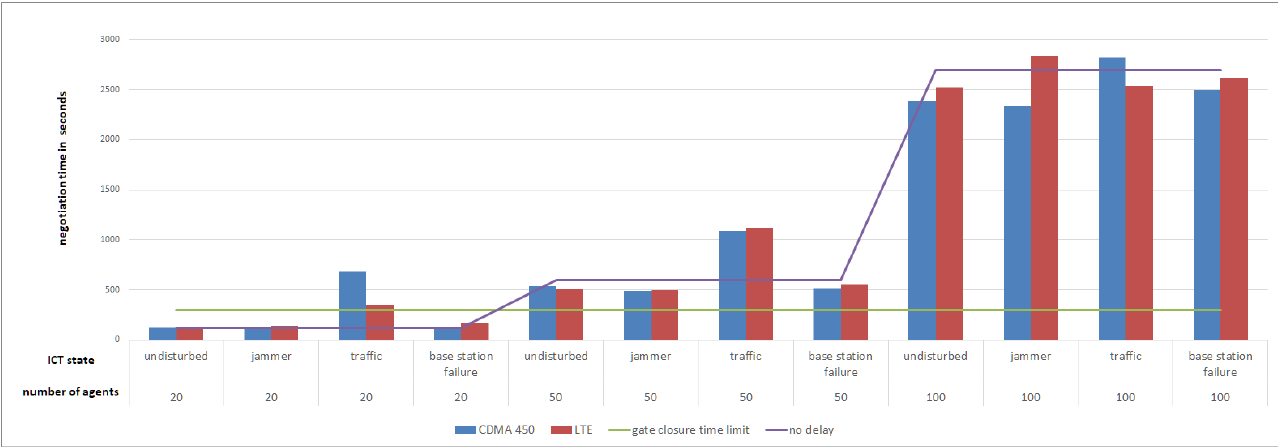
Figure 8. Negotiation time for both communication technologies and different scenarios. From left to right: the scaled numbers of agents in the VPP for the different ICT